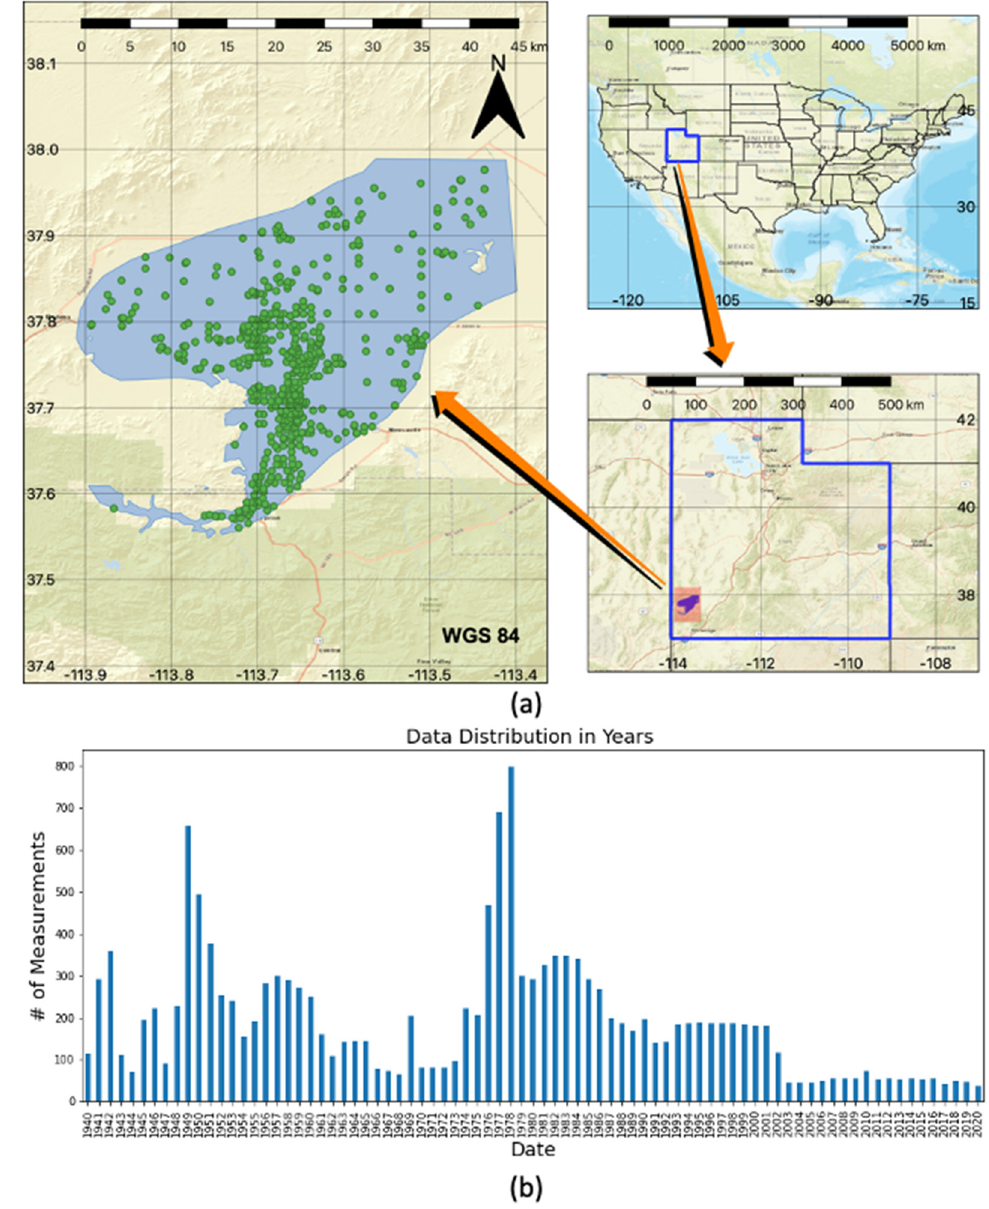
Figure 2. ( a ) The spatial distribution of the wells and ( b ) the temporal distribution of the measure- ments in years for the Beryl-Enterprise aquifer in Utah.